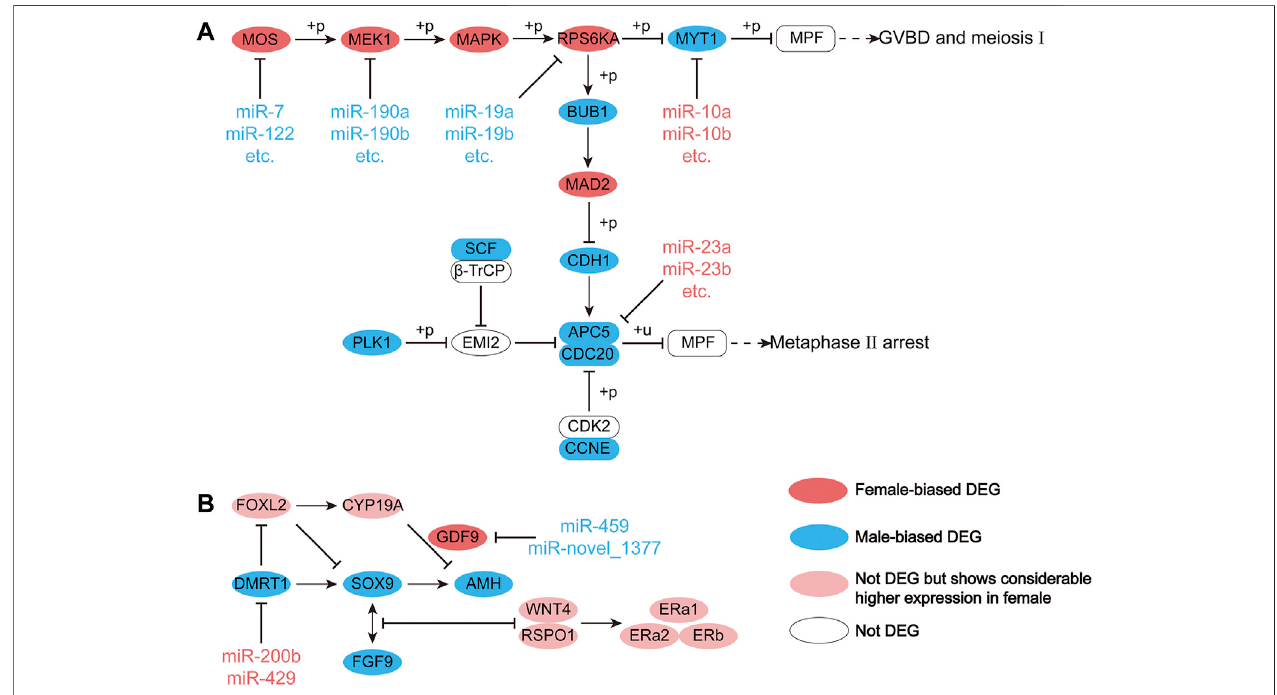
FIGURE 7 | Regulation of miRNA on differential gene expression (DEG) in the (A) meiotic pathway of oocytes and (B) antagonistic gonadal function maintenance pathway during the sexual maturity period.